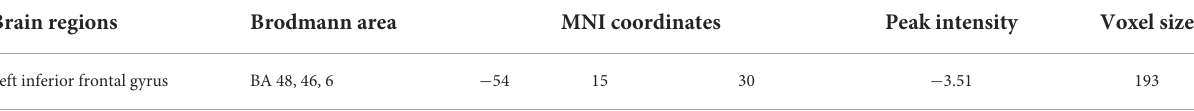
TABLE 3 The detailed information for between-group functional connectivity differences (dorsal caudate as